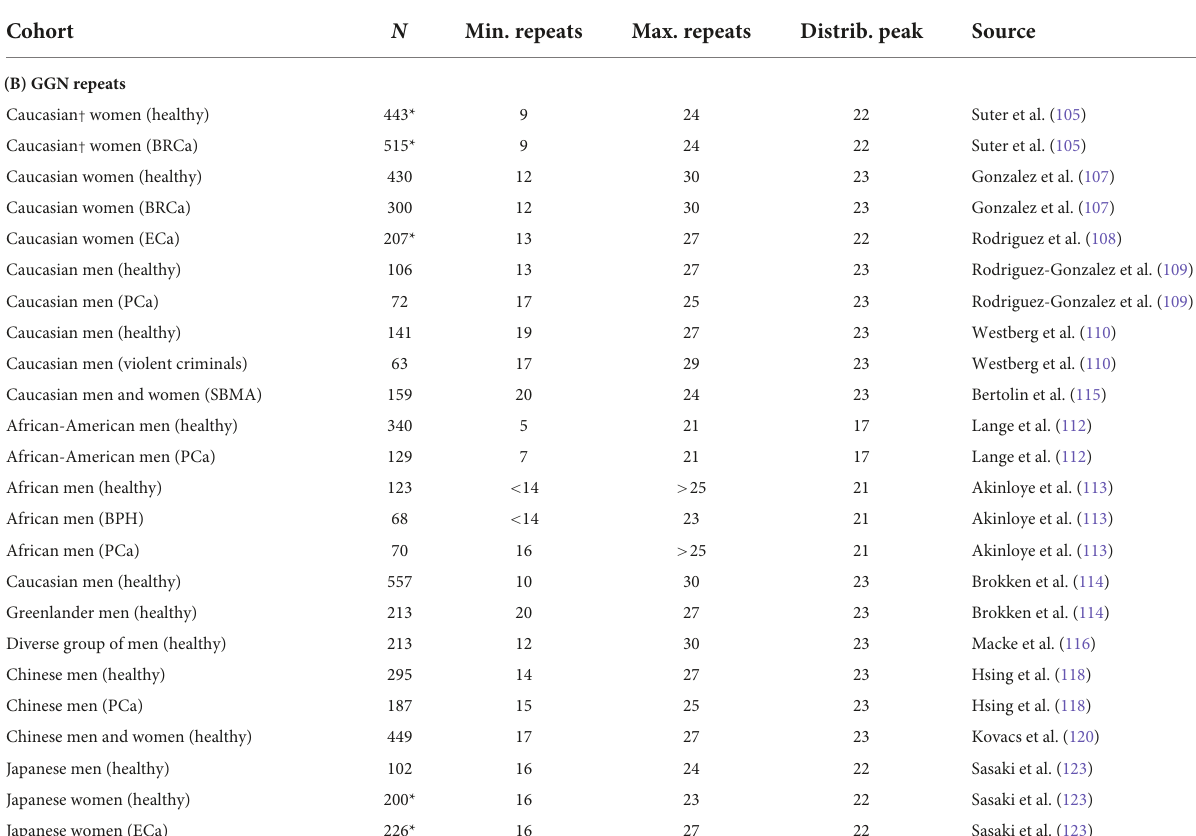
∗ Aswomenhave2Xchromosomes,therealsamplesizeofARallelesgenotypedwastwotimeshigher. † 89%Caucasian,5%Asian,4%AfricanAmerican,1%AmericanIndian,1%Hispanic. # 73%WhiteBrazilian,25%Afro-Brazilian,3%Asianorigin.PCa,prostatecancer;BPH,benignprostatehyperplasia;BRCa,breastcancer;ECa,endometrialcancer;SBMA,spinal-bulbar